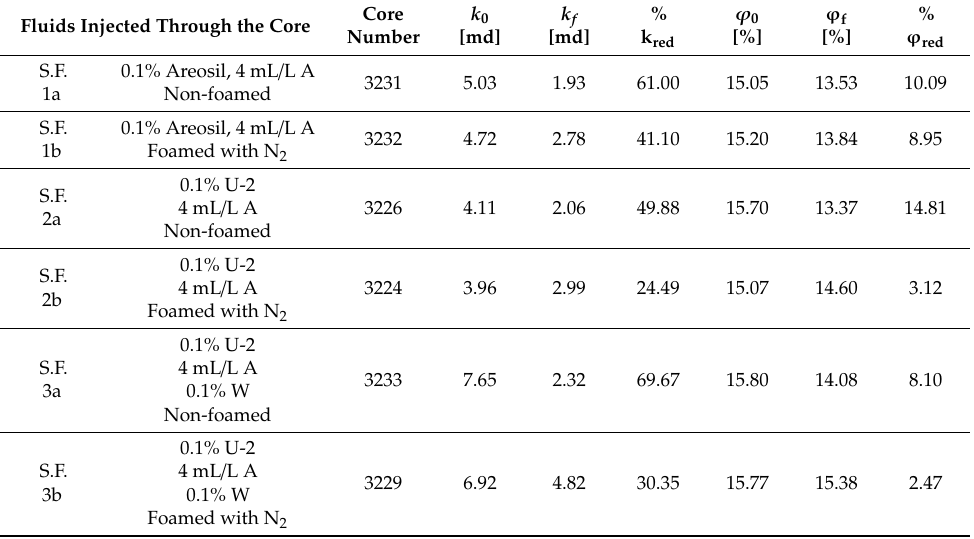
Table 5. Results of the porosity ratio and permeability coe ffi cient measurement before and after the performance of damaging